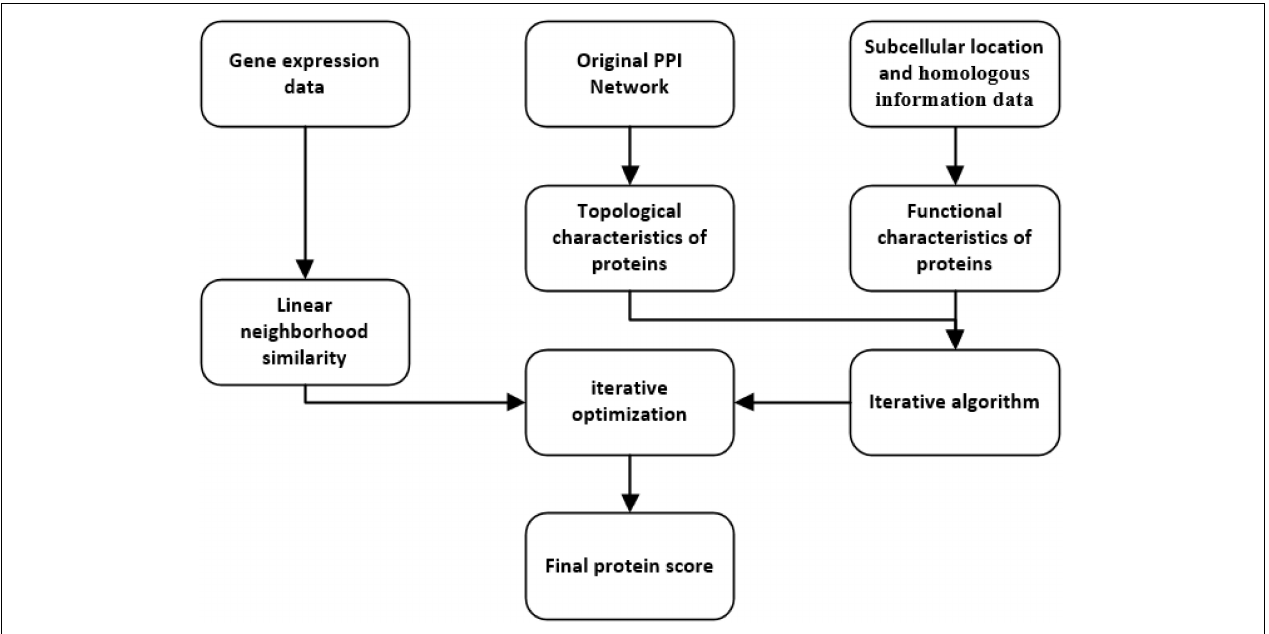
FIGURE 1 | Flowchart of the